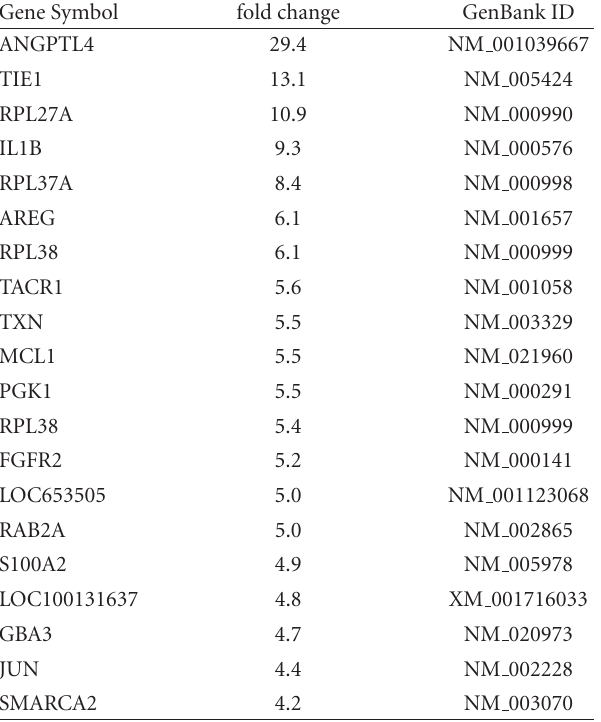
Table 3: Microarray Analysis of A375(DRO) cells after TZD/ rexinoid combination treatment—2-fold up regulated with ROSI alone.